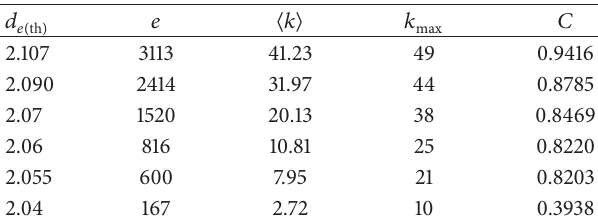
Table 4: Statistical characteristic parameters of electrical distance- based network model of TJ220